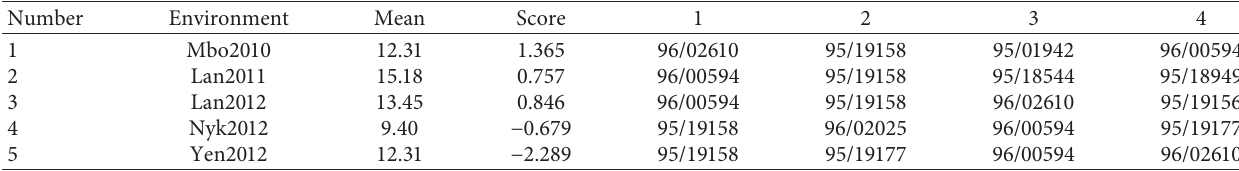
Table 6: First four AMMI selections per environment.